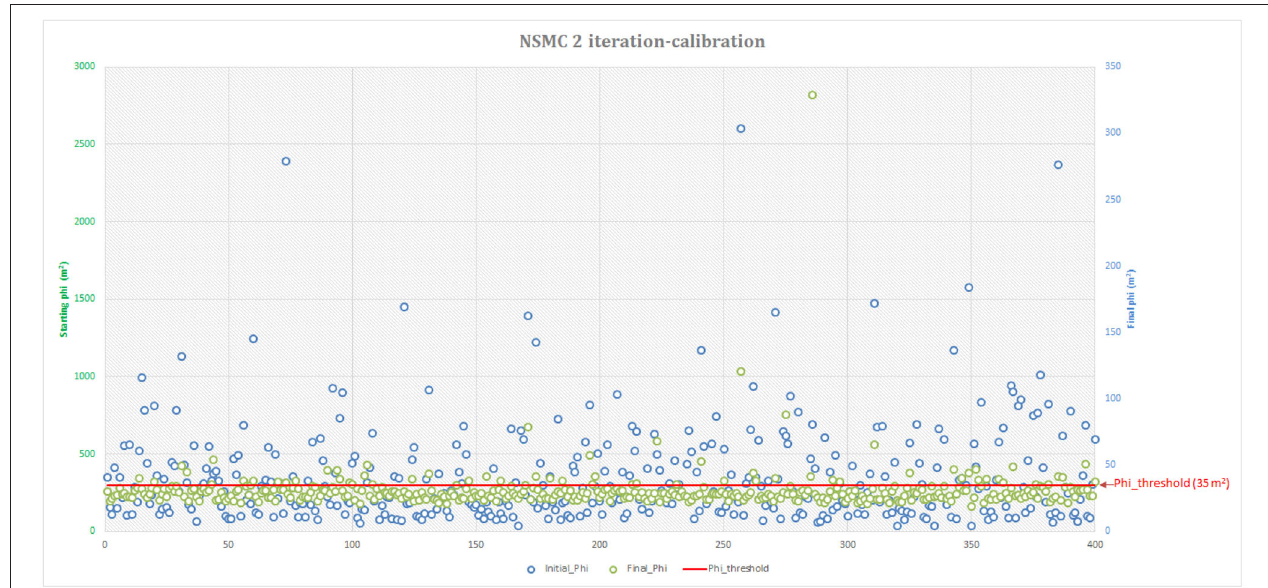
FIGURE 5 | Comparison between the initial objective function (RANDPAR) and the final objective function obtained with the two-iteration process (SVD). The red line represents the threshold objective function limit (35 m 2 ) used to retain the models with a good misfit to track particles.